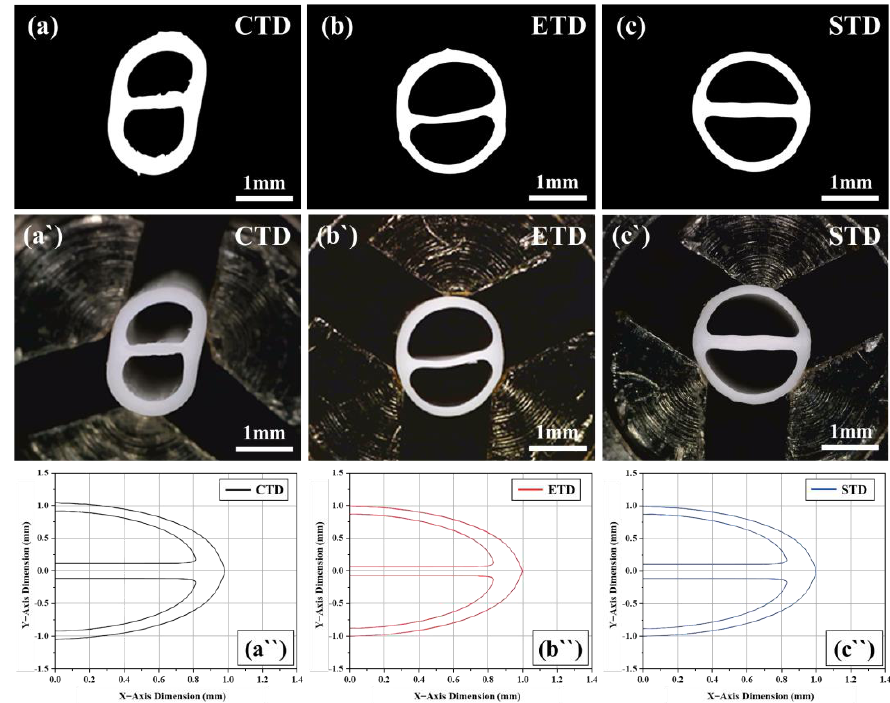
Table 5. Dimensional specifications of multi lumen tubes made by different tip and die models.